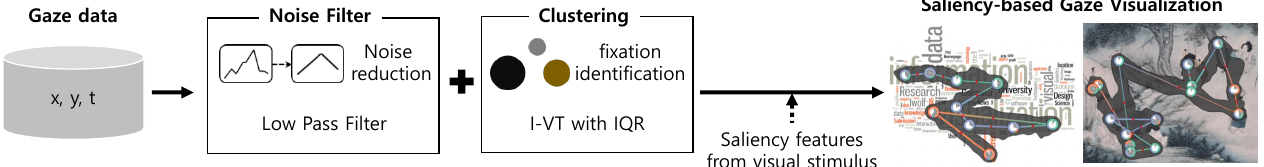
Figure 1. An overview of the data processing. The gaze data and saliency features are visualized together in the saliency- based gaze visualizations. Saliency features are extracted from visual